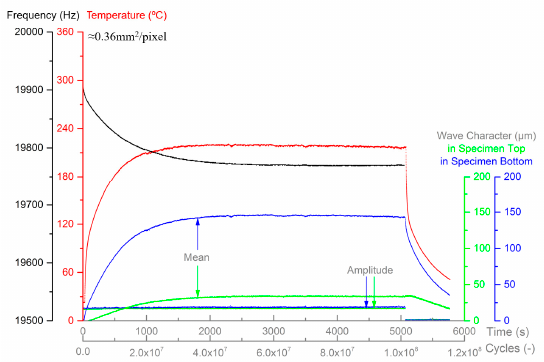
Figure 2. Data acquisition interface ( R = − 1, f = 20 kHz, N f = 1 ∗ 10 8 , no crack).